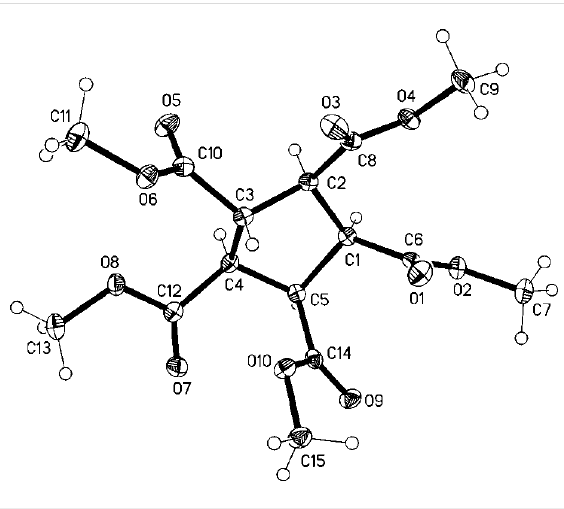
Figure 3: Structure of 26 in the crystal; ellipsoids represent 30% prob- ability